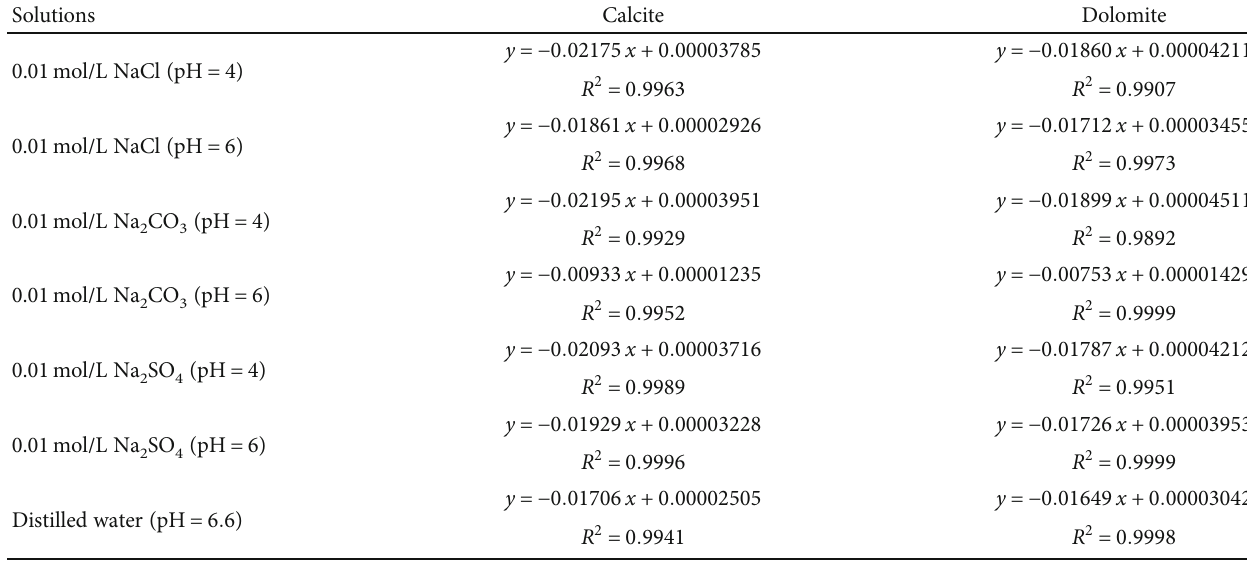
Table 9: Noyes-Whitney equations and correlation coe ffi cients of calcite and dolomite in static solutions.